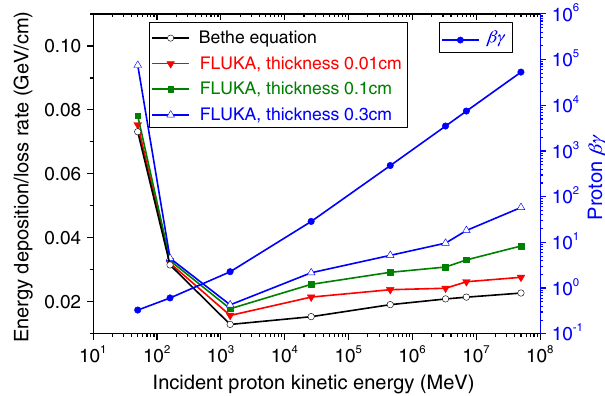
FIG. 9. Energy deposition or loss rate per proton in a thin copper target as a function of kinetic energy ranging from 50 MeV to 50 TeV. Comparisons are made between FLUKA simulations (energy deposition per target length) and direct calculations using the Bethe equation (energy loss rate). For the simulation results, three target thicknesses are considered as denoted in the